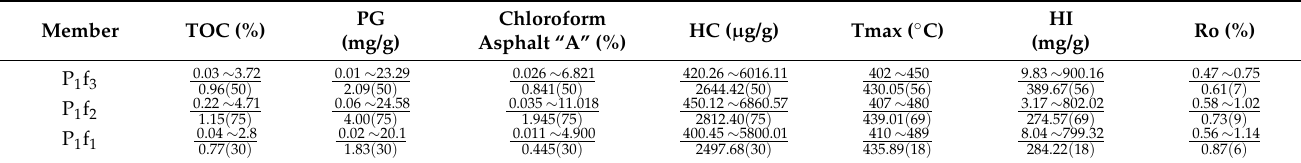
Table 1. Geochemical characteristics of different members of shale in the Fengcheng Formation of the Mahu Sag.